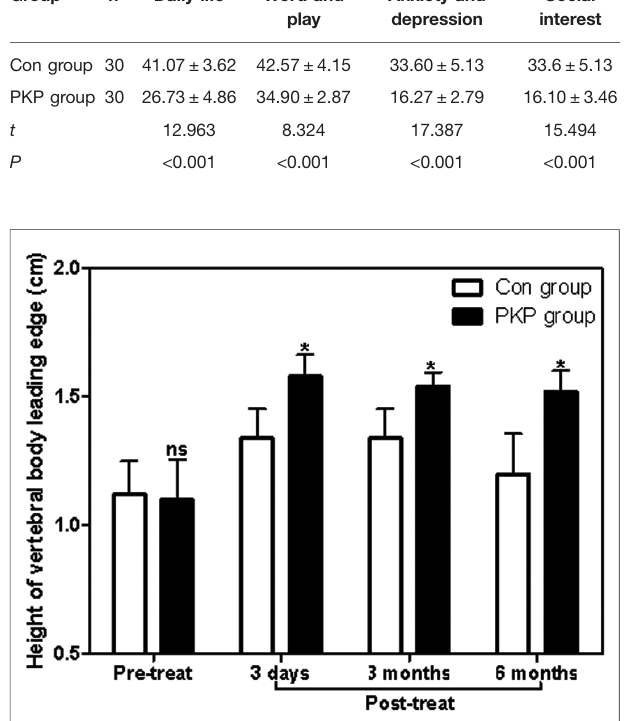
FIGURE 2 | Comparison of the vertebral body leading edge height at different times between two groups. Note: Compared with the Con group, ns P >0.05 and * P <0.05.